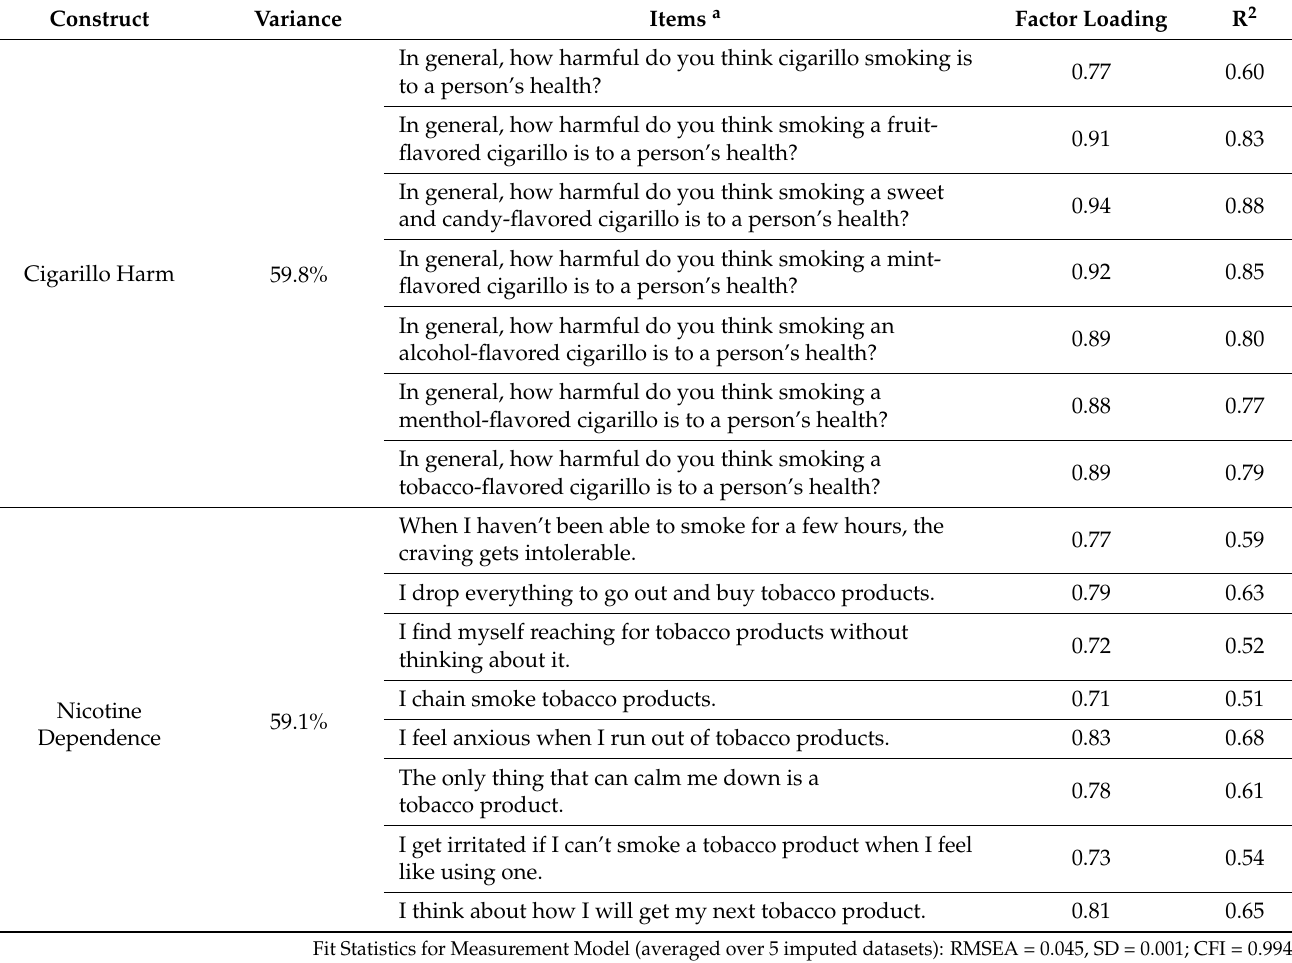
Table 2. Standardized Factor Loadings for Items Assessing Perceived Cigarillo Harm and Nicotine Dependence Among Young Adults Who Used Cigarillos and Cannabis in the Past 30 Days (N =